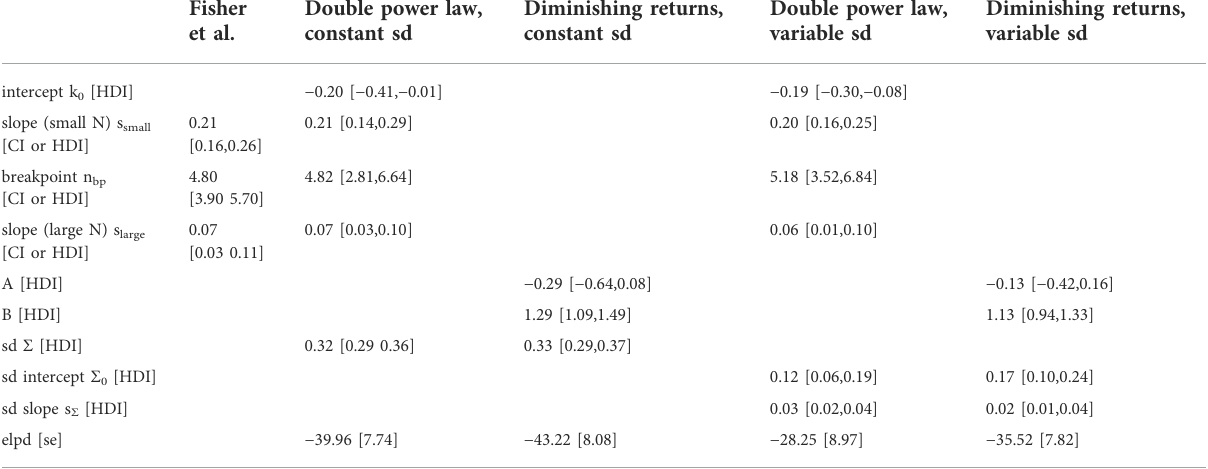
TABLE 1 Estimates of model parameters and model comparison. The power law parameters reported by Fisher et al, (2013); Fisher et al., 2020) ( fi rst column)areordinaryleast-squares estimatesandtheintervalsarecon fi denceintervals(CIs).FortheBayesianmodelsdescribedinthispaper(last 4 columns) parameters are given as the mean of the posterior together with the 95% highest density interval (HDI). The Bayesian models assume a normal distribution of the data in log space with the regression curve as the mean. Intercept , slope (small N) , breakpoint and slope (large N) parameterize the regression curve of the double power law, whereas A and B parameterize the regression curve of the ‘ diminishing returns ’ model, sd is the standard deviation of the normal distribution in the models that keep the standard deviation constant. Sd intercept and sd slope parametrizealinearincreaseofthestandarddeviationwithlog-cellnumberinthemodelsthatallowthestandarddeviationtovary.Theexpected log predictive density (elpd) and its standard error (se) was calculated for the Bayesian models using leave-one-out cross-validation. Fisher et